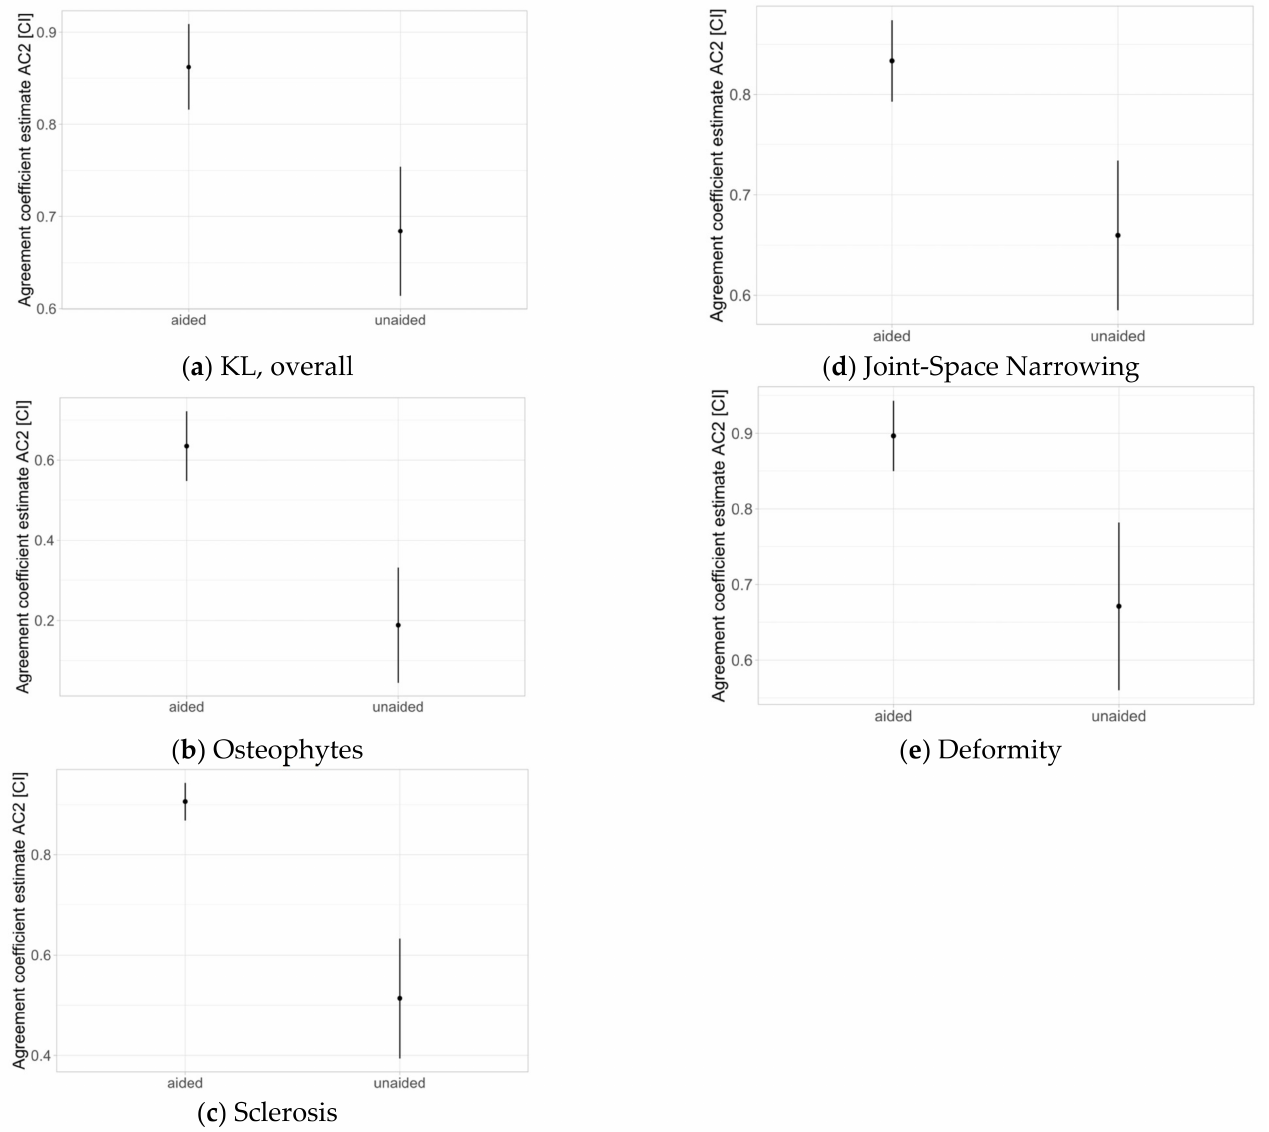
Figure 2. Inter-rater reliability (IRR) for the overall KL ( a ) score, as well for each subdomain (os- teophytes ( b ), sclerosis ( c ), joint-space narrowing ( d ), deformity ( e )); AC2 = agreement coefficient estimate; CI = confidence